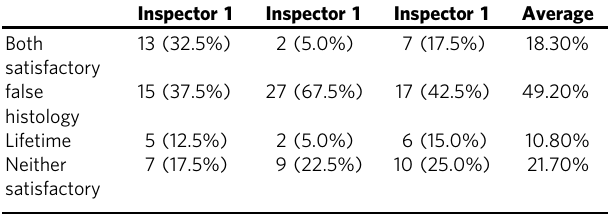
Table 1 Blind inspection of the registration